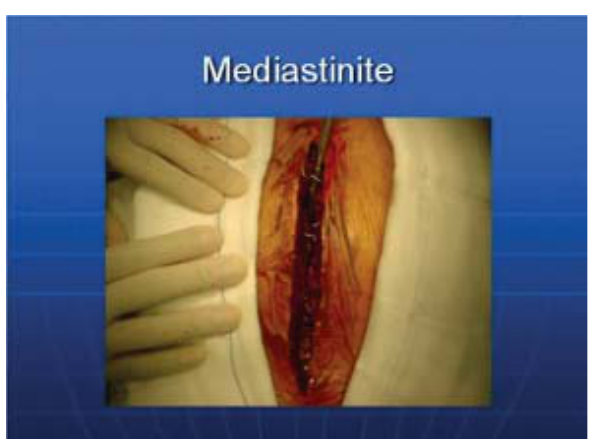
Fig. 1 - Deiscência total da ferida esternal, após cirurgia de revascularização do mioocárdio